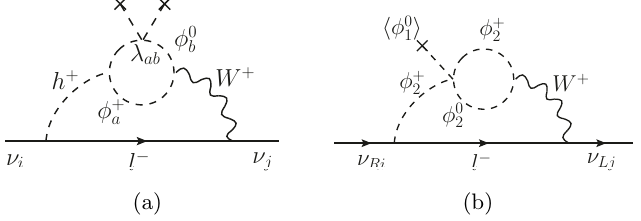
Figure 7 . (a) Two-loop neutrino mass contribution in the BFZ model. The NMM can be computed by attaching the photon line to any of the charged particles inside the loop. (b) A similar diagram for the model with Dirac